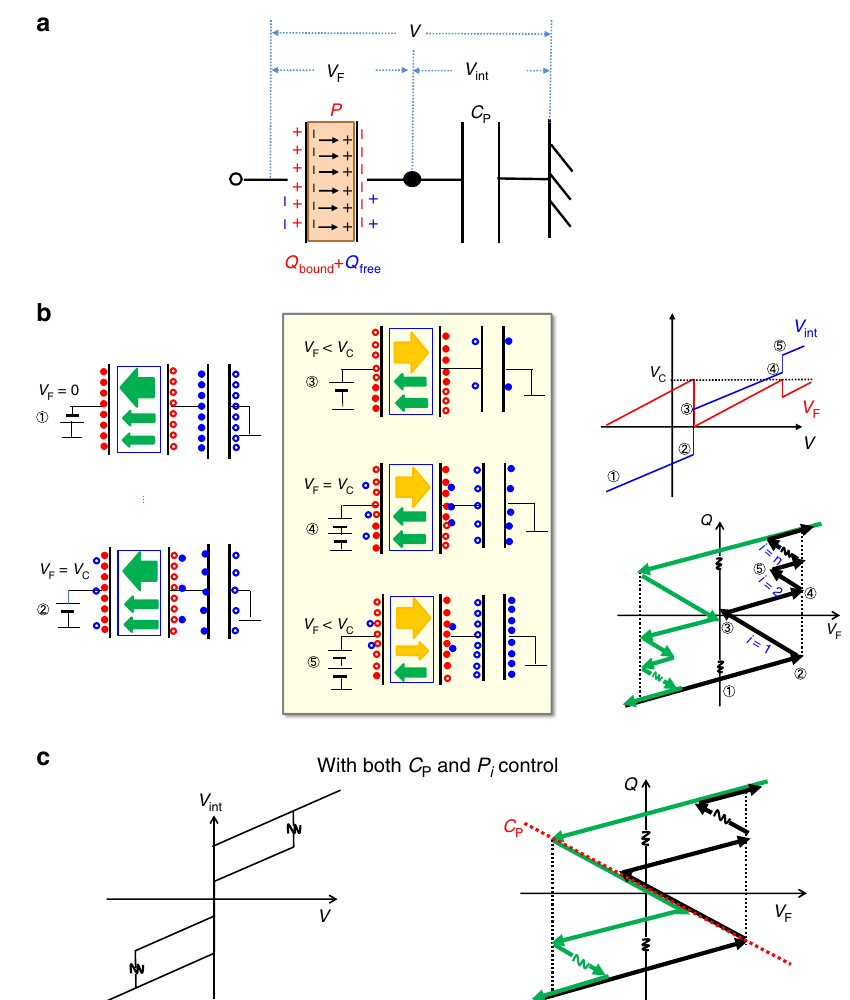
Fig. 4 Electrostatic understanding of stepwise V int jumps in FE/PE stacks. a Schematics of FE/PE system. Two kinds of charges are involved in FE-CAP: bound charges ( Q bound ) and free charges ( Q free ). b Understanding of charge dynamics (circles and dots represent holes and electrons respectively), voltage change and Q - V F characteristics in FE/PE system with successive multiple-domain fl ips. c A possible case that the biggest V int jump in the forward V sweeping may overlap partly with that in the backward one, then the subthreshold hysteresis in FE/PE gate stack FET may be much reduced in the overlapping V int range if the bias dependence of semiconductor is